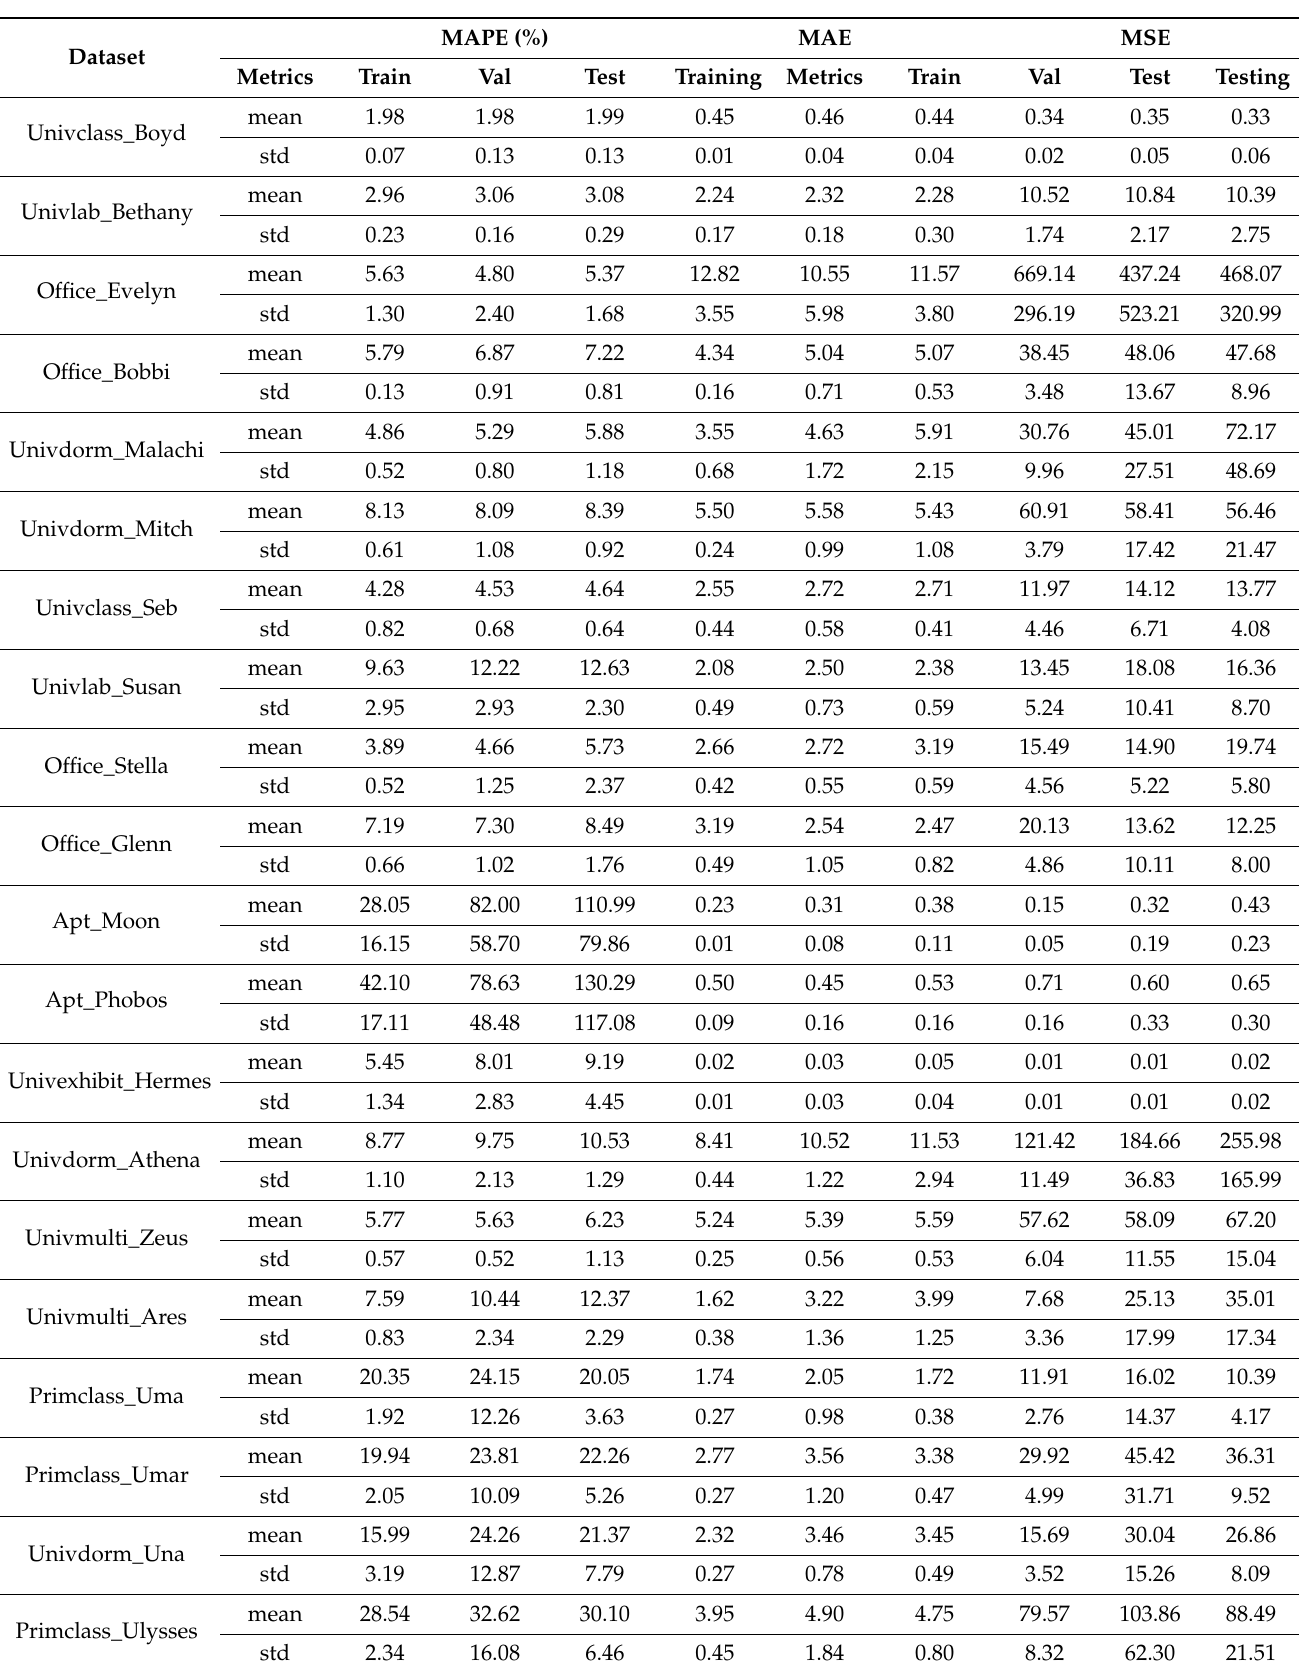
Table 12. The cross-validation result of forecasting using LSTM without